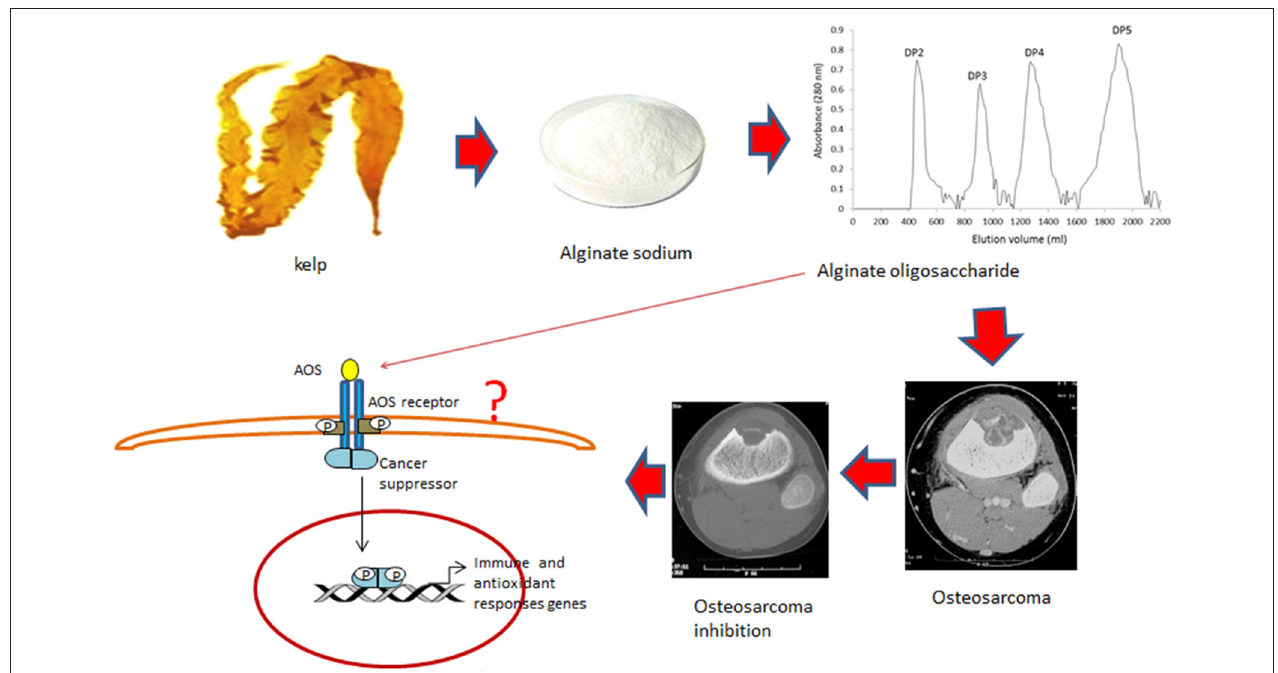
FIGURE 8 | Cartoon illustrations of alginate oligosaccharide (AOS) inhibiting the growth of osteosarcoma and recurrence. AOS may bind the receptor on the membrane of osteosarcoma cells and activate cancer suppressors, which improve antioxidant and anti-inflammatory properties of OS patients.